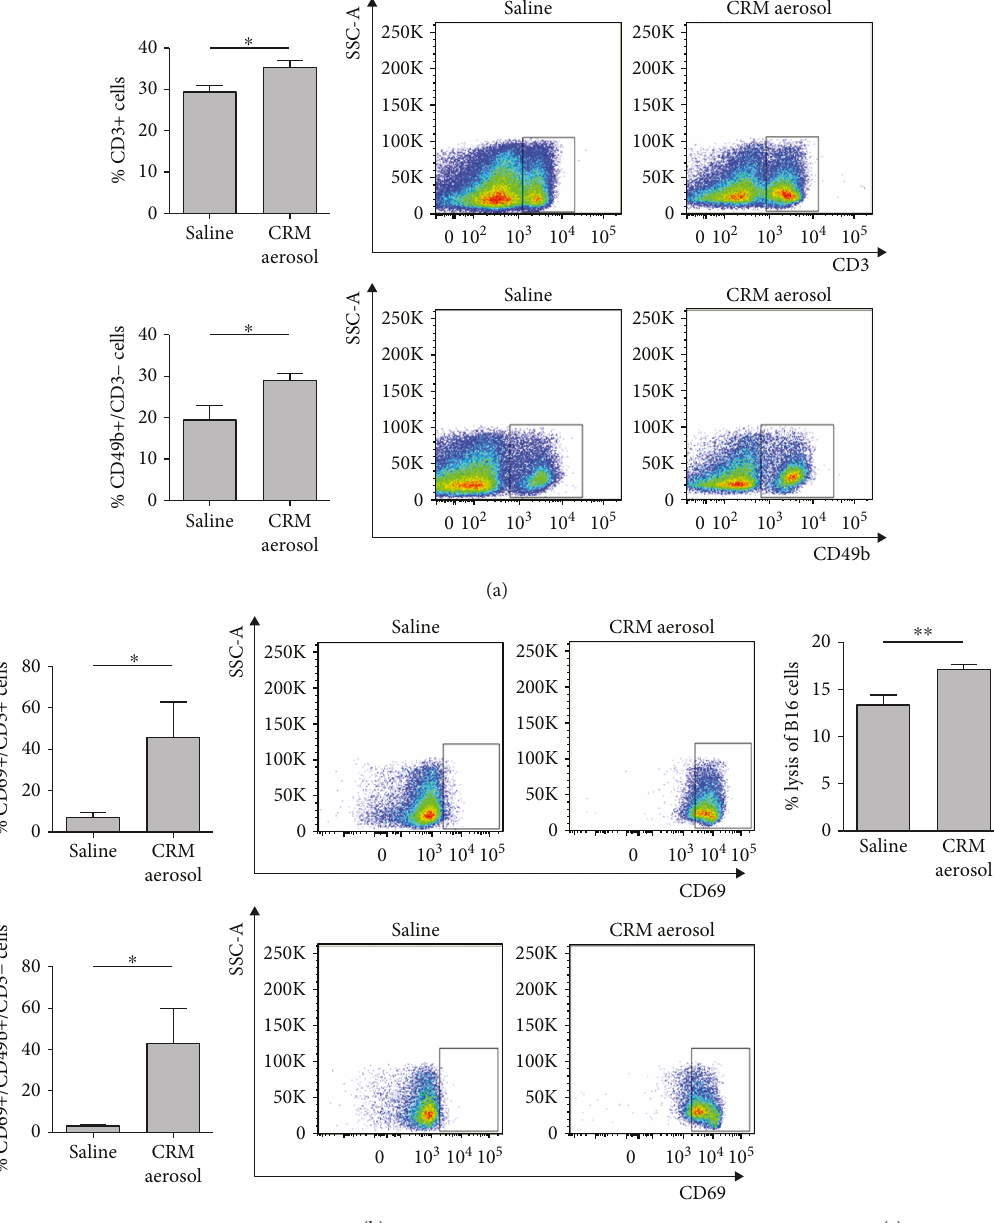
Figure 3: E ff ects of CRM aerosolization on the recruitment and activation of lung antitumor e ff ector cells. Bars ( mean ± SEM ) and representative dot plots of the percentage of NK cells (identi fi ed as CD45+/CD3-/CD49b+ cells) and T cells (identi fi ed as CD45+/CD3+ cells) (a) and of CD69 expressing NK and T cells (b) evaluated in 4 mice/group injected with B16 melanoma cells and aerosolized with saline or combined CRMs. Bars ( mean ± SEM ) represent the percentage of the speci fi c lysis of B16 target cells cultured for 4h with nonadherent cells obtained from the lung suspensions of 4 mice/group (c). ∗ p ≤ 0 05 , ∗∗ p ≤ 0 01 by Student ’ s t